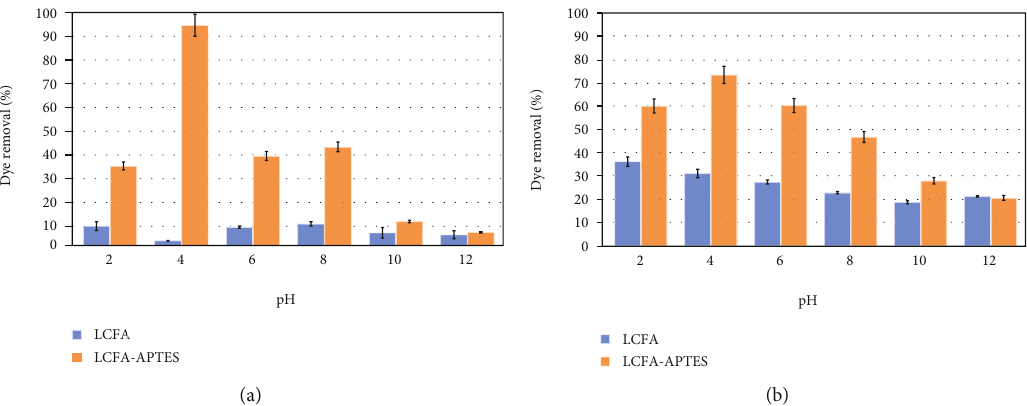
Figure 6: E ff ect of pH on dye removal percentage: (a) MO ( t = 5 min , T = 25 ° C , amount of adsorbent 10mg) and (b) XO ( t = 5 min , T = 25 ° C , amount of adsorbent 20mg) by LCFA and LCFA-APTES. The error bars represent the standard deviation of at least three repeated measurements at each pH